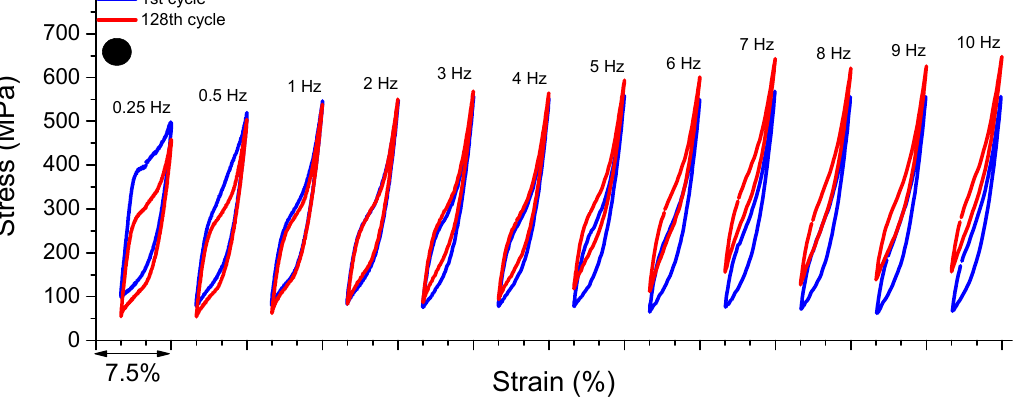
Figure 7. Dynamic response of the superelastic behavior of the reference element for loading frequencies from 0.25 Hz to 10 Hz.